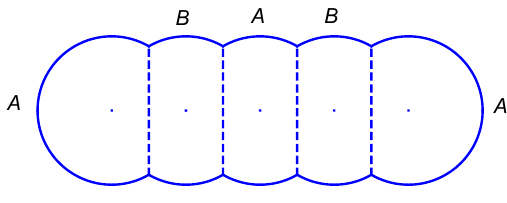
Figure 13 . Cartoon of bulk Euclidean spacetime for our long wormhole. A=B vacuum regions are marked on the boundary, and domain walls are shown as dashed lines. The left-most and right-most A regions are endcaps which admit only a single domain wall. All other regions allow two. This is the unique Euclidean spacetime compatible with such boundary